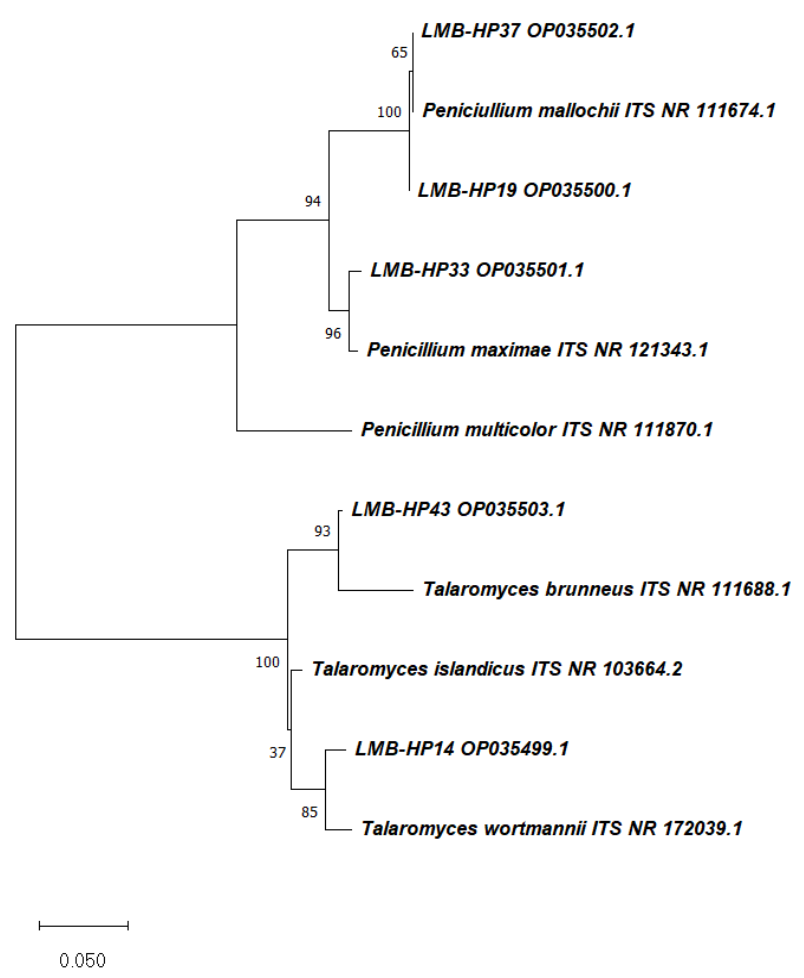
Figure 2. Representative maximum likelihood (ML) phylogenetic tree using Internal Transcribed Spacer (ITS) region of selected pigment-producing strains. The numbers next to the branches indicate the percentage of trees which have the associated taxa clustered together. The scale bar indicates the number of substitutions per site.